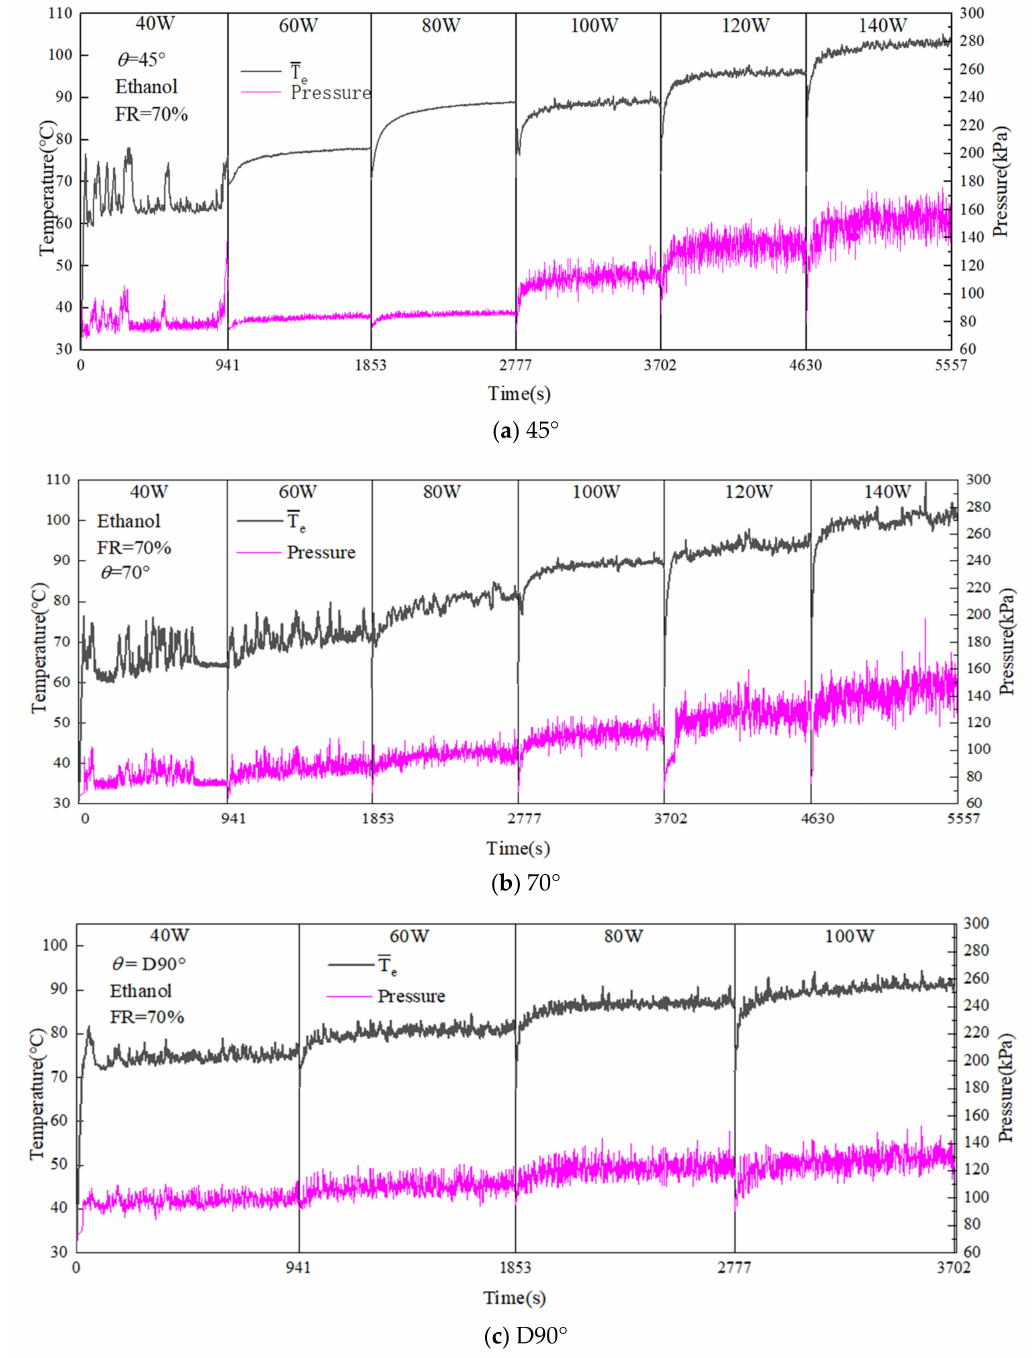
Figure 6. Variation of temperature and internal pressure of evaporation section with time under different installation angles of ethanol working